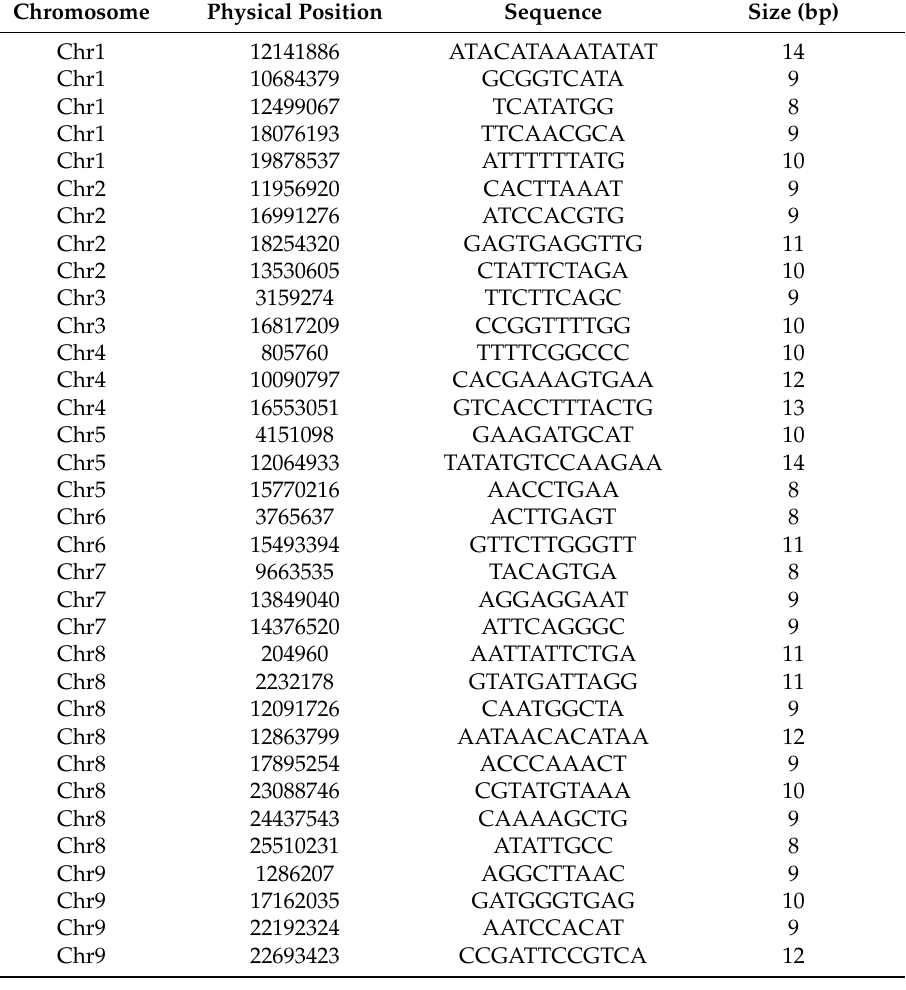
Table 5. Information about deletions of length ≥ 8 bp identified in this